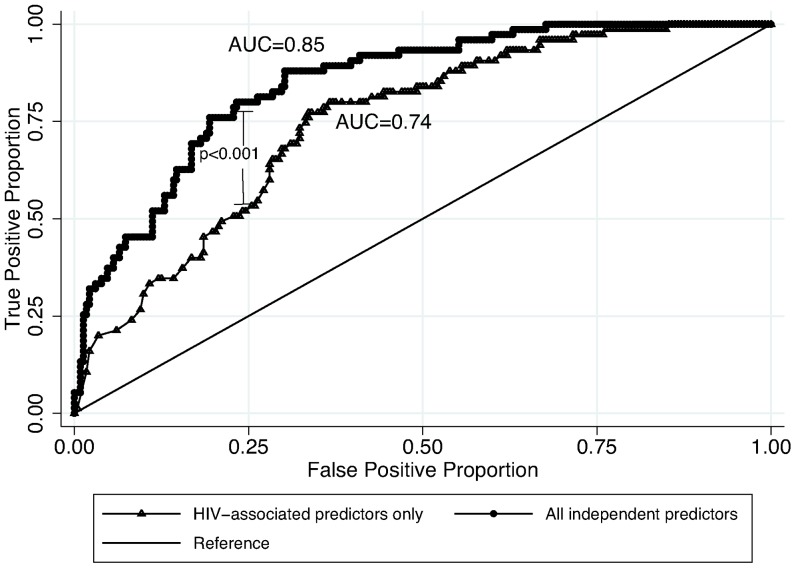
Receiver operating characteristic curves of final logistic regression model containing all independent predictors (sex, CD4 count, HAART status, fever, heart rate, hemoglobin, and sodium) compared to logistic regression model with HIV-associated predictors only (CD4 count and HAART status only) [CD4 = CD4+ T-cell count; HAART = highly active anti-retroviral therapy; AUC = area under the curve].